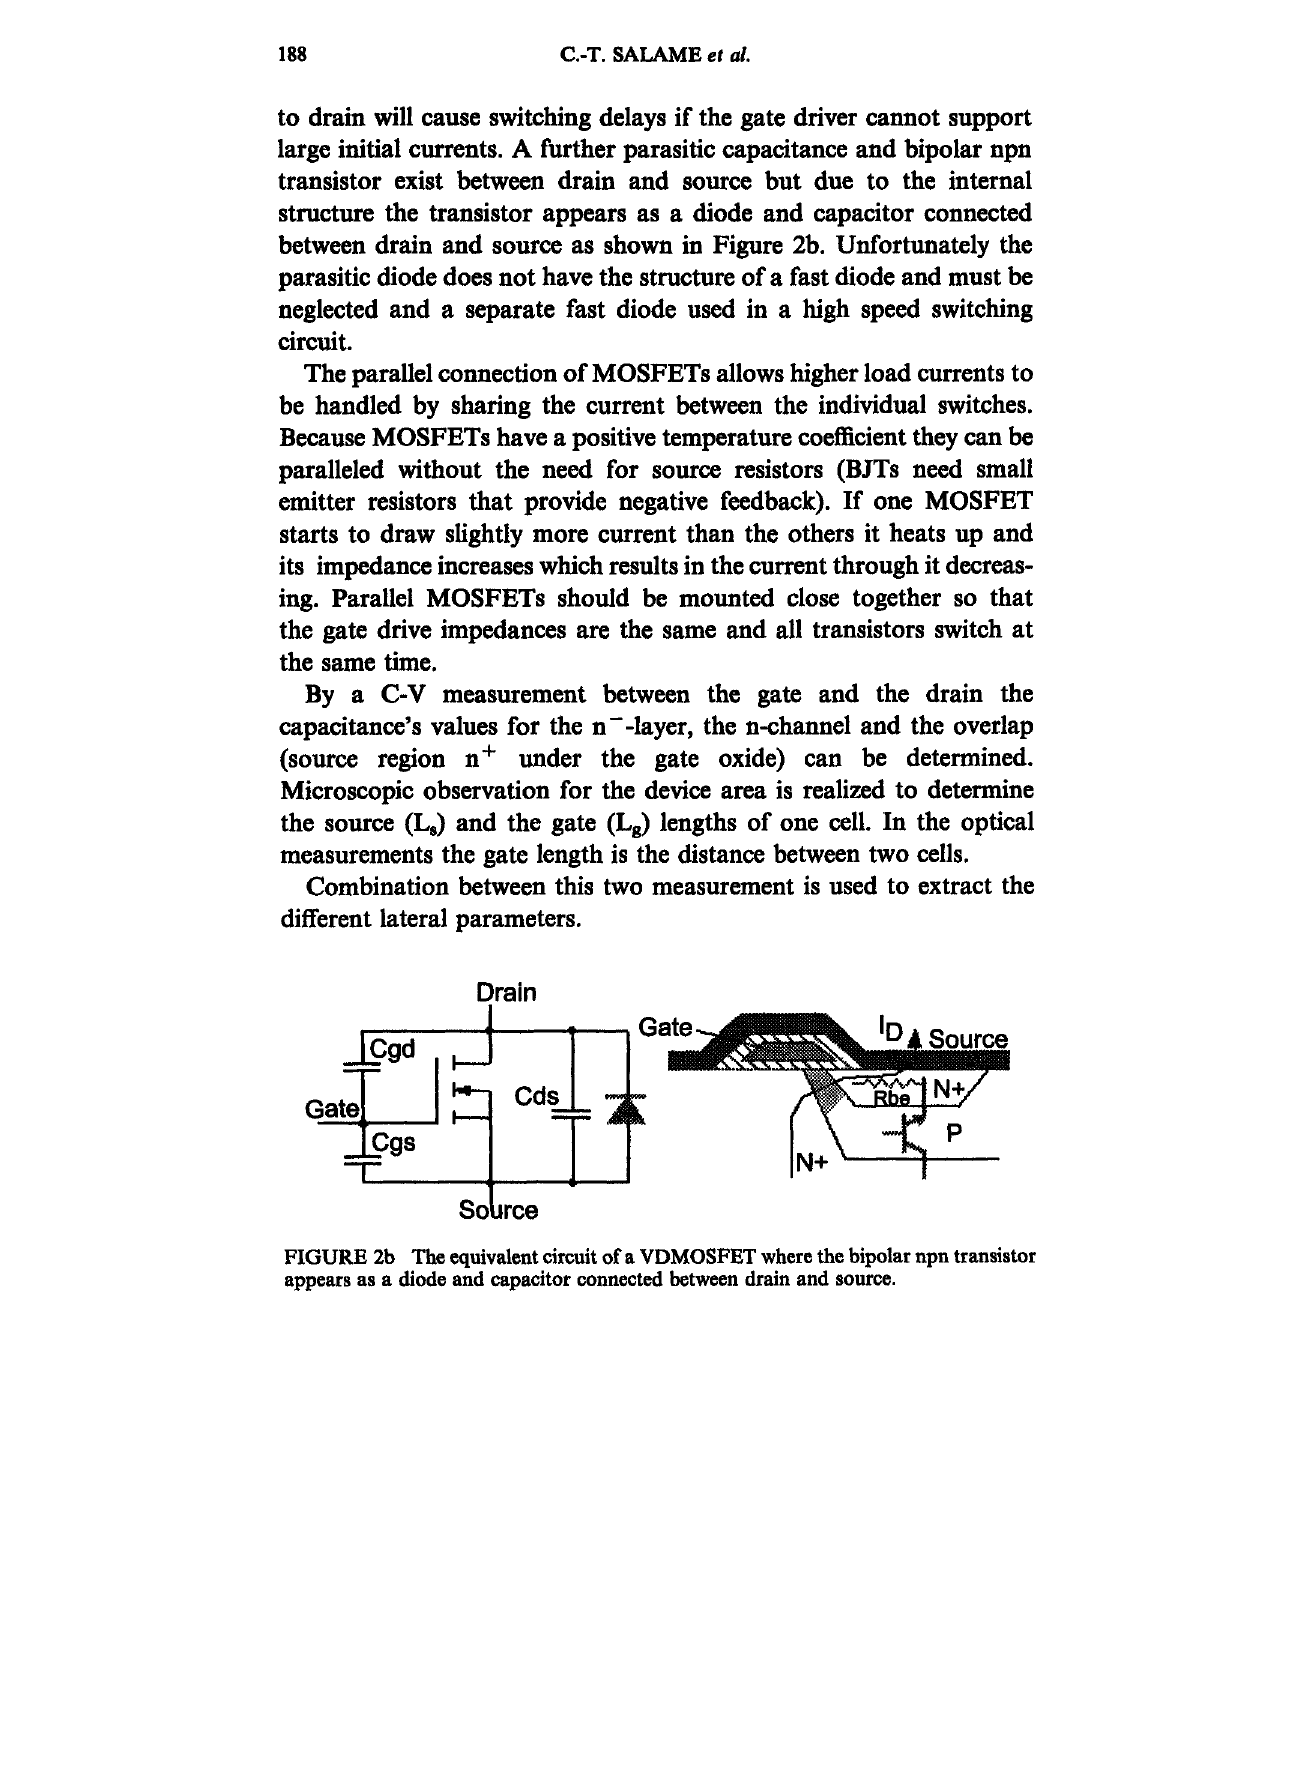
FIGURE 2b The equivalent circuit of a VDMOSFET where the bipolar npn transistor appears as a diode and capacitor connected between drain and